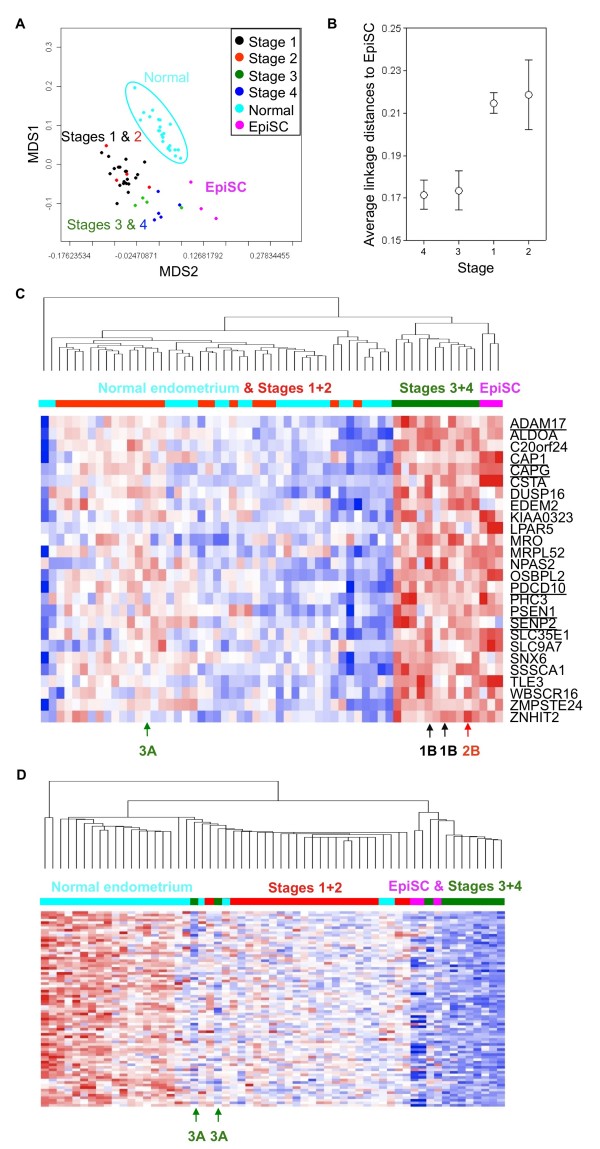
Expression of EpiSC gene patterns in EECs, especially late ones. (A) Relationships between normal endometrium, EECs of different stages in the training data set and epithelial stem cells (EpiSCs). This MDS plot was drawn by the 217 features differentiating early and late EECs. (B) Average linkage distances between tissues and EpiSCs. The same 217 probe sets were used. The confidence limits shown represent the standard error. (C) A heat map shows genes overexpressed in both EpiSCs and late EECs. Gene symbols of these genes are shown. Genes associate with tumor malignancy or stem cell biology are underlined. (D) A heat map shows the distribution patterns of the 77 probe sets down-regulated in late EECs. These genes are also absence in EpiSCs.